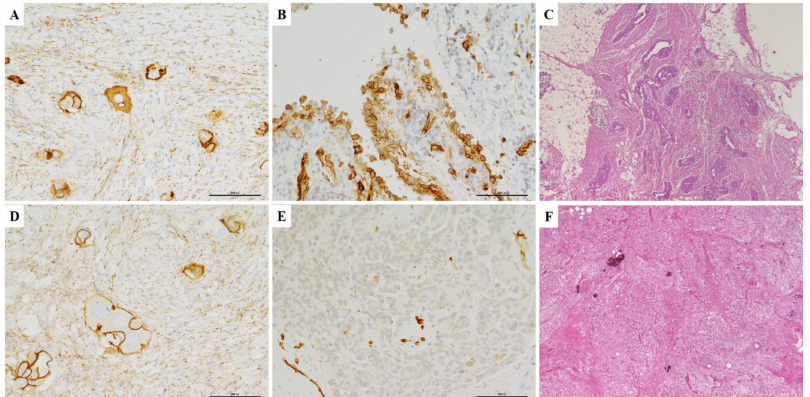
Figure 2. Omental pathological response according to β -catenin and AQP1 IHC. ( A , B ) Diagnostic biopsy of a case of high grade serous ovarian carcinoma demonstrating aberrant membranous and cytoplasmic staining for β -catenin ( A ) and diffuse positivity for AQP1 ( B ). ( C ) After NACT and IDS, this case showed an omental response score of 1: mainly viable tumor with no or minimal regression-associated fibro-inflammatory changes. ( D – E ) Another serous ovarian carcinoma case showing normal membranous staining for β -catenin (D) and negative staining for AQP1 ( E ). ( F ) After NACT and IDS, this case showed an omental response score of 3: extensive fibro-inflammatory changes with no residual tumor identified (A-B-D-E: IHC, LSAB-HRP, 20 × ); (C-F: IHC, H&E, 20 × ).